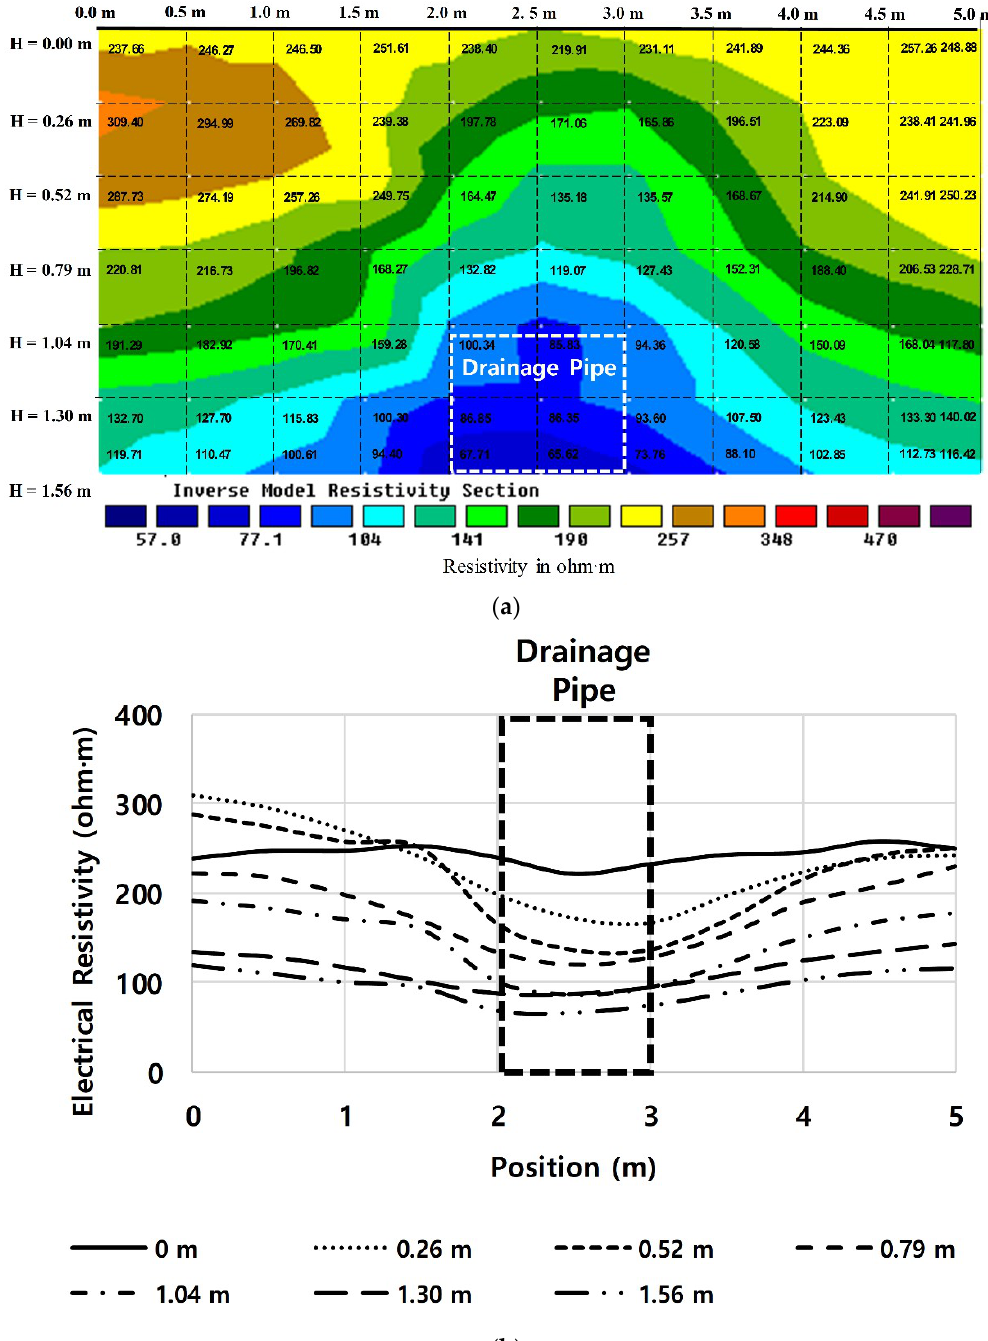
Figure 12. Test result for the drainage pipe (Section No. 8). ( a ) Distribution of the ER. ( b ) ER according to the position at each depth. to the position at each